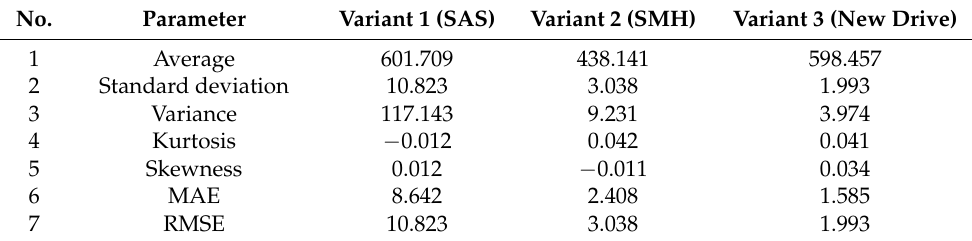
Table 2. Statistical description and errors of hourly electric energy consumption by each of the analyzed drives, obtained in Monte Carlo simulations. MAE: mean absolute error; RMSE: root mean squared error.